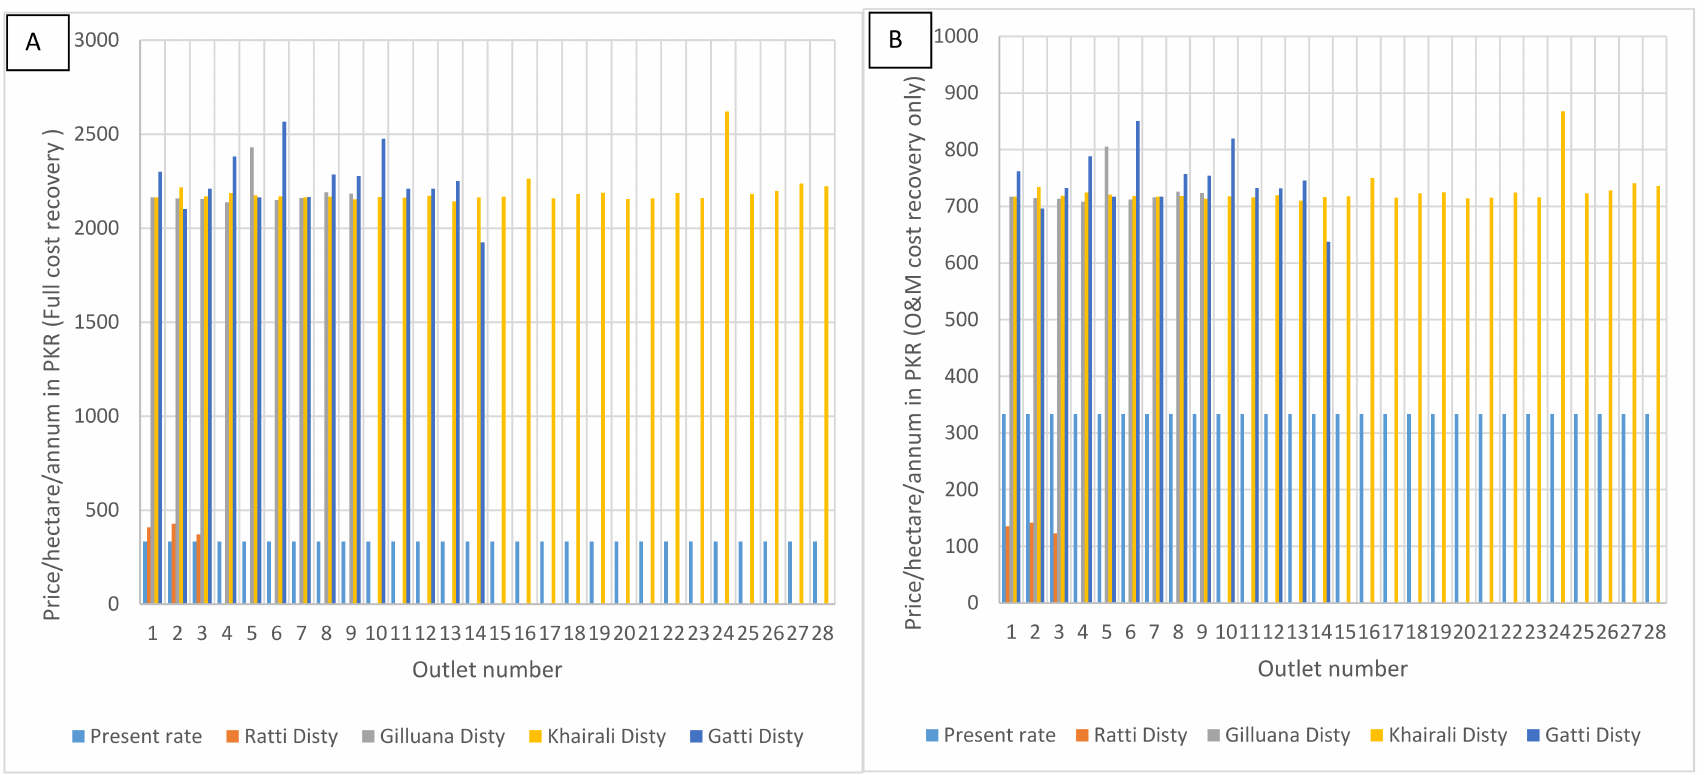
Figure 9. Recommended irrigation water prices for the selected distributaries to recover: ( A ) the full cost of O&M; ( B ) infrastructure maintenance cost